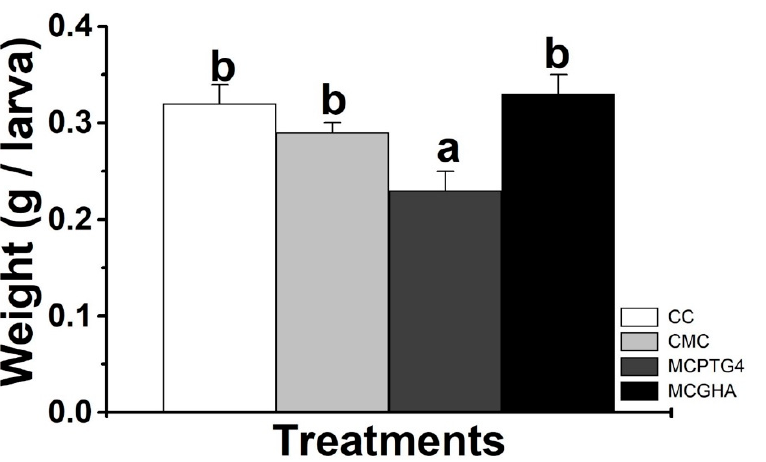
Figure 2. S. frugiperda sixth instar larval weight after feeding on plants from the specified treatments. CC: Negative control, CMC: Negative control with only methylcellulose, MCPTG4: B. bassiana fungal strain PTG4 with methylcellulose, MCGHA: B. bassiana fungal strain GHA with methylcellulose. Analysis done with Duncan’s post-hoc multiple range test ( α = 0.05) after one-way ANOVA. Graphical bars with the same letters indicate that there were no significant differences among them.